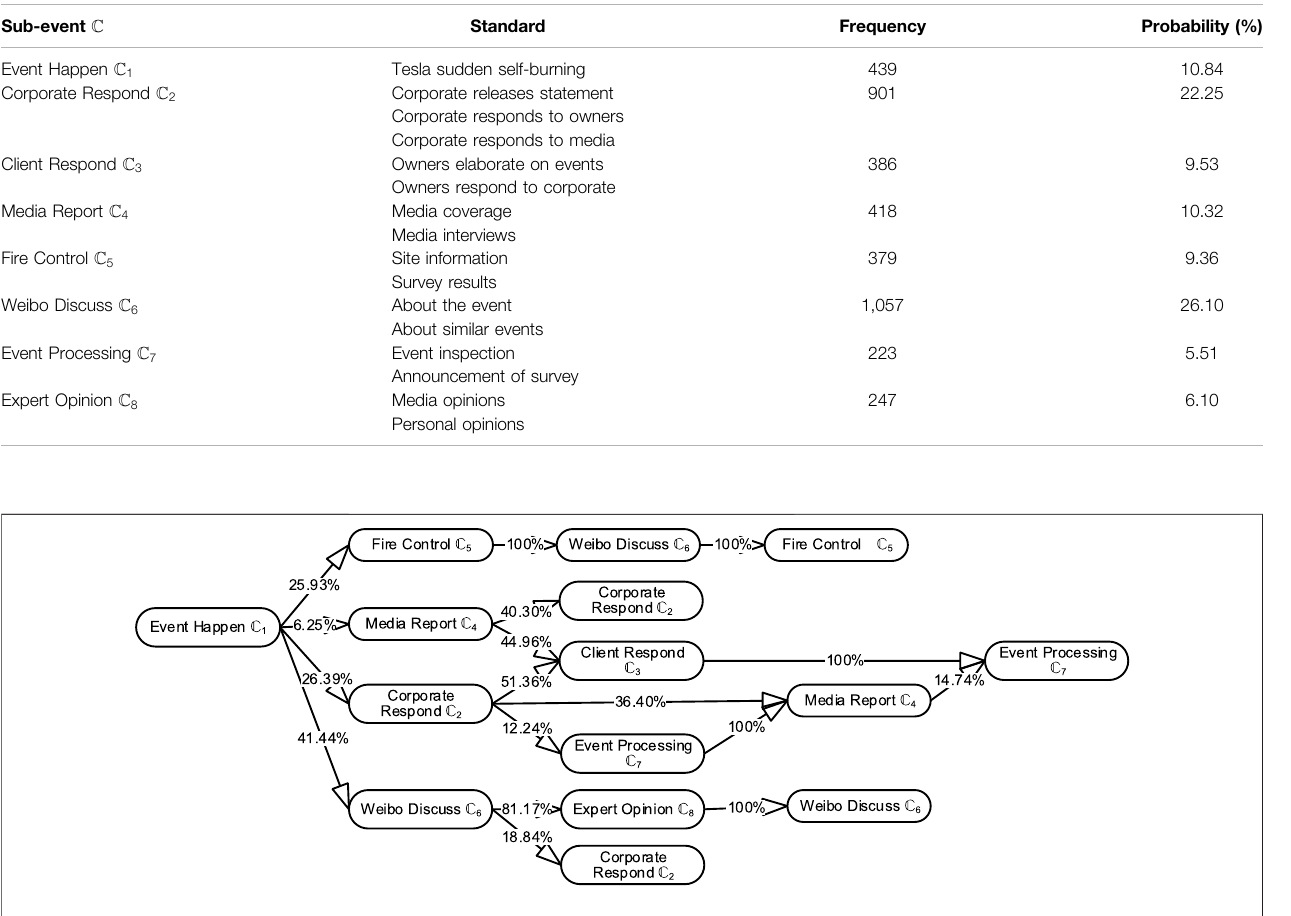
TABLE 2 | Label information of sub-events.